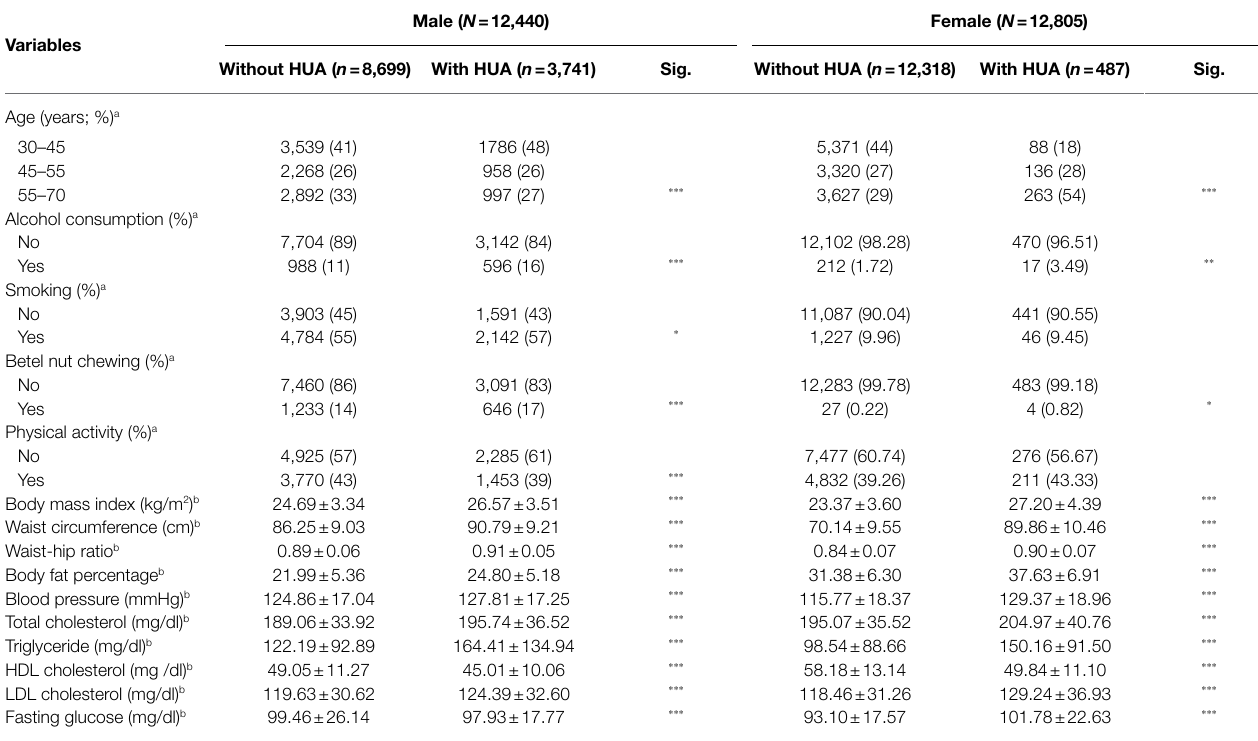
TABLE 1 | Baseline characteristics of the participants. Male ( N = 12,440) Female ( N = 12,805) Variables Without HUA ( n = 8,699) With HUA ( n = 3,741) Sig. Without HUA ( n = 12,318) With HUA ( n = 487)